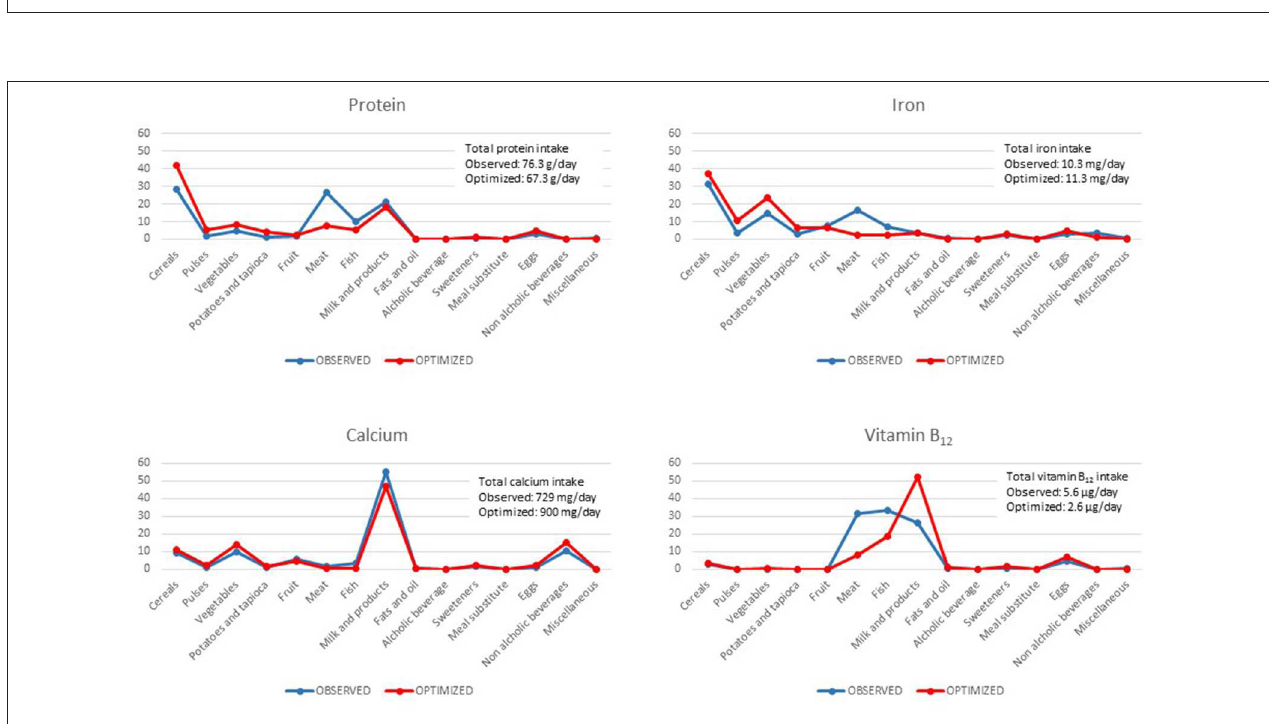
FIGURE 2 | Percentage contribution of food categories to total intake of selected nutrients (protein, iron, calcium, and vitamin B 12 ) in observed and optimized diet in the female adult population.